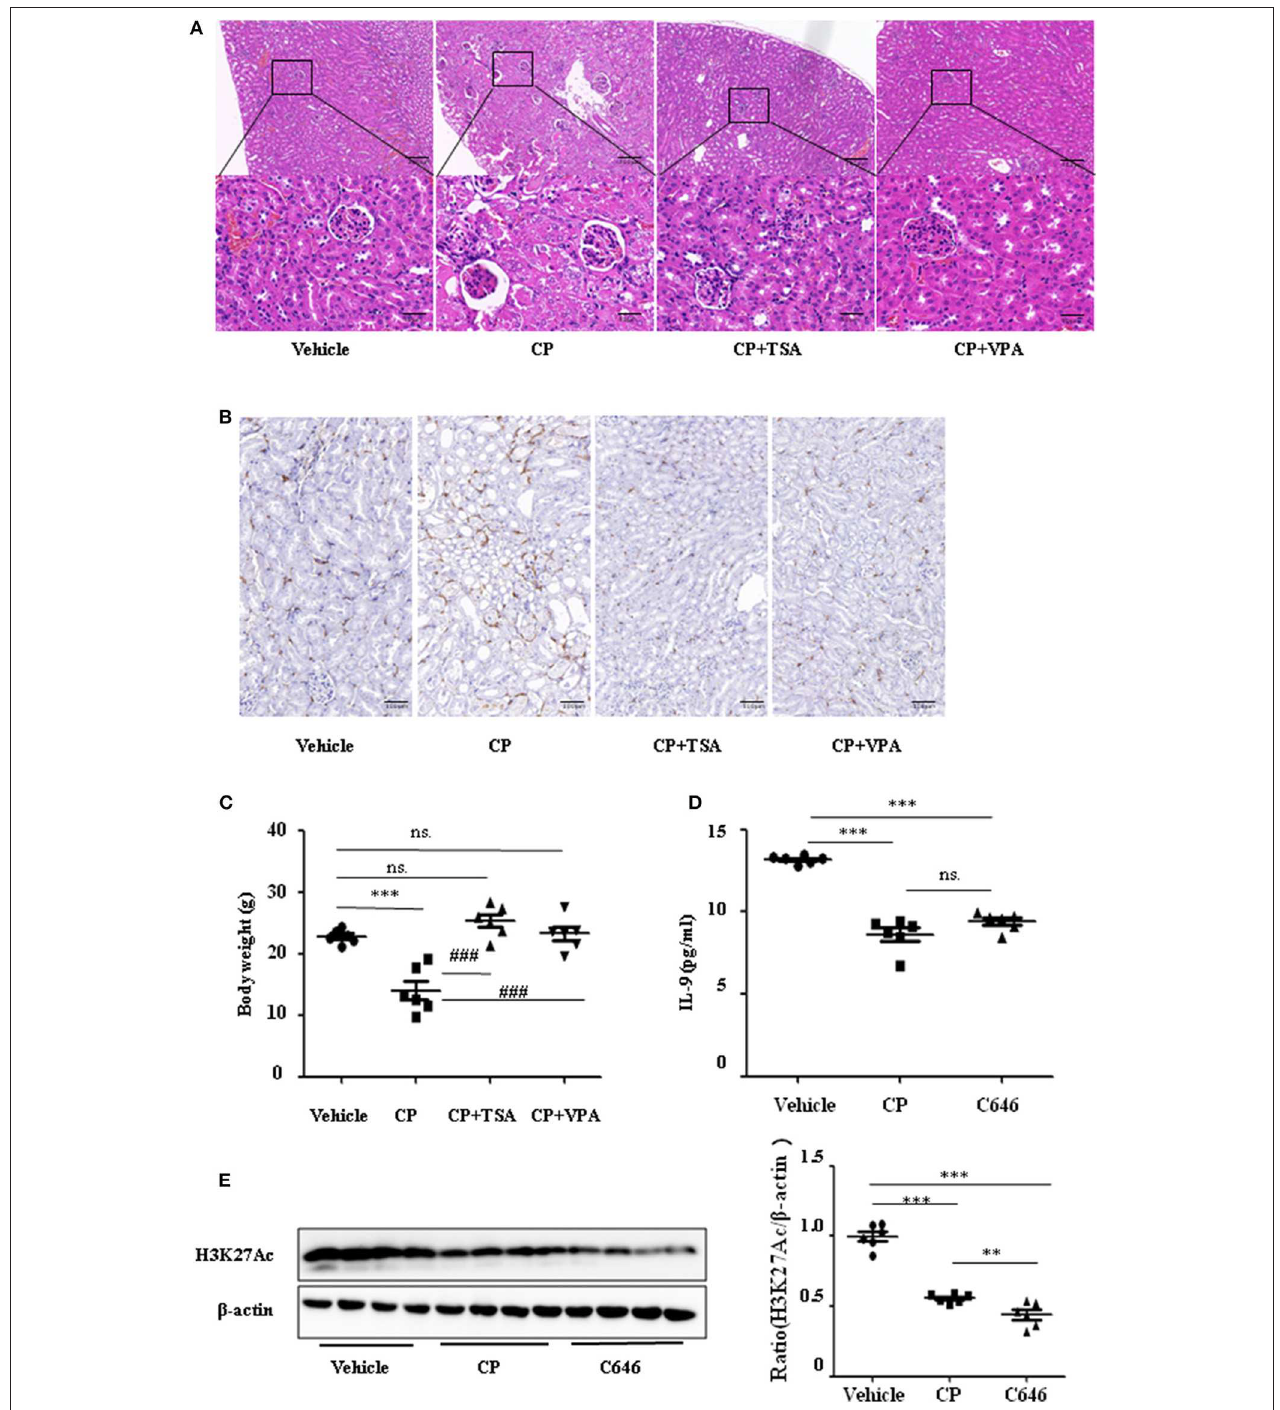
FIGURE 7 | Histone deacetylase (HDAC) inhibitors suppressed interleukin-9 (IL-9) with cisplatin (CP) administration in vivo . Three independent experimental series were performed with six animals per group in each series. Data are represented as mean ± SD ( n = 6). (A) Representative images of H&E staining of kidney section with CP-induced acute kidney injury (AKI) mice with administration of trichostatin A (TSA; 1 mg/kg body weight) or valproate (VPA; 1 mg/kg body weight), respectively. *** P < 0.001 vs. the vehicle group; ### P < 0.001 vs. the CP group. Magnification: × 10 and × 40. (B) Representative images of Immunohistochemistry staining infiltrated macrophages. Magnification: × 40. (C) Body weight in each group during injection. *** P < 0.001 vs. the vehicle group; ### P < 0.001 vs. the CP group. (D) The level of IL-9 in CP-induced AKI mice with administration of C646 by ELISA. *** P < 0.001 vs. the vehicle group. (E) Western blot was performed on CP-induced AKI mice with administration of C646 to determine H3K27Ac expressions. Each lane represents one sample from an individual mouse. Dot plots show the corresponding quantification of band intensity and fold change. *** P < 0.001, ** P < 0.01 vs. the vehicle group.